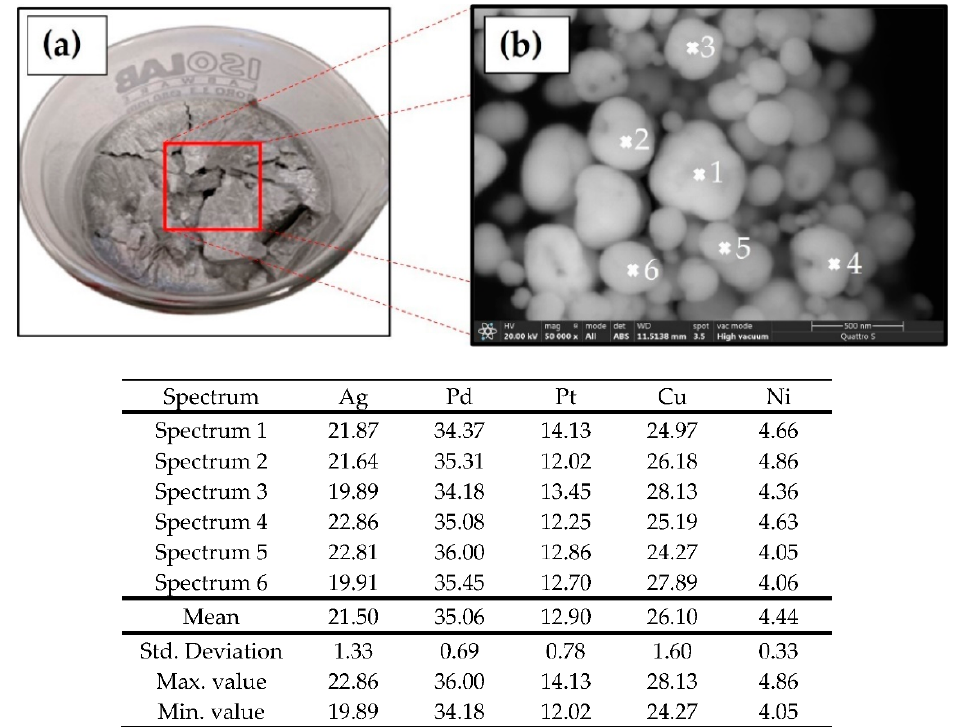
Figure 8. CCNPs: ( a ) Macro-view and ( b ) SEM microstructure showing places for EDS analysis.